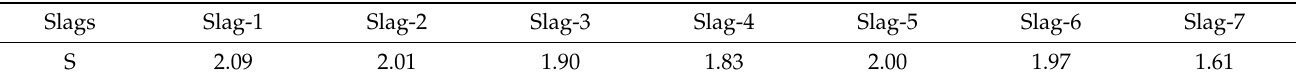
Table 5. Slag stability of the slags